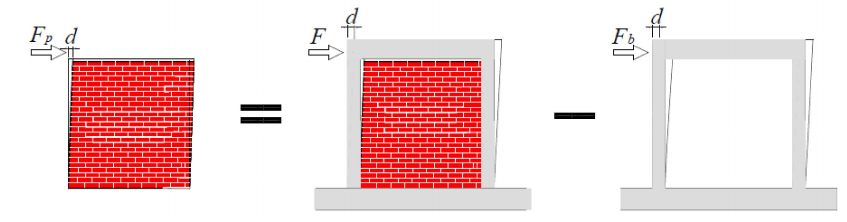
Figure 11. Parallel model